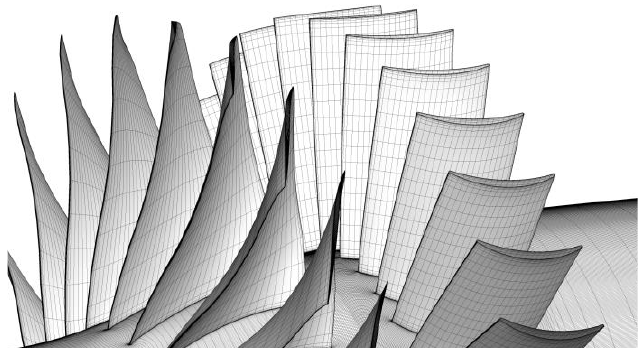
Figure 2. Computational meshes for NASA Stage 67.